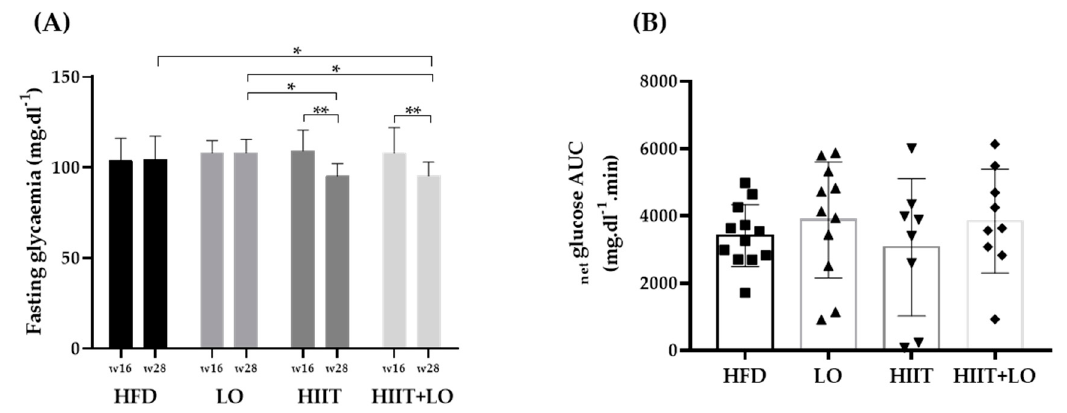
Figure 5. Fasting glycemia and net glucose AUC during the oral glucose tolerance test at week 28 (end of phase 2) in the four groups: HFD ( n = 12), LO ( n = 11), HIIT ( n = 8), and HIIT+LO ( n = 9). ( A ) Fasting glycemia (mg.dL − 1 ) at week 16 and week 28 in the four groups. ( B ) Net glucose AUC (mg.dL − 1 .min − 1 ) at week 28. AUC: Area under the curve. * p < 0.05, ** p < 0.01.